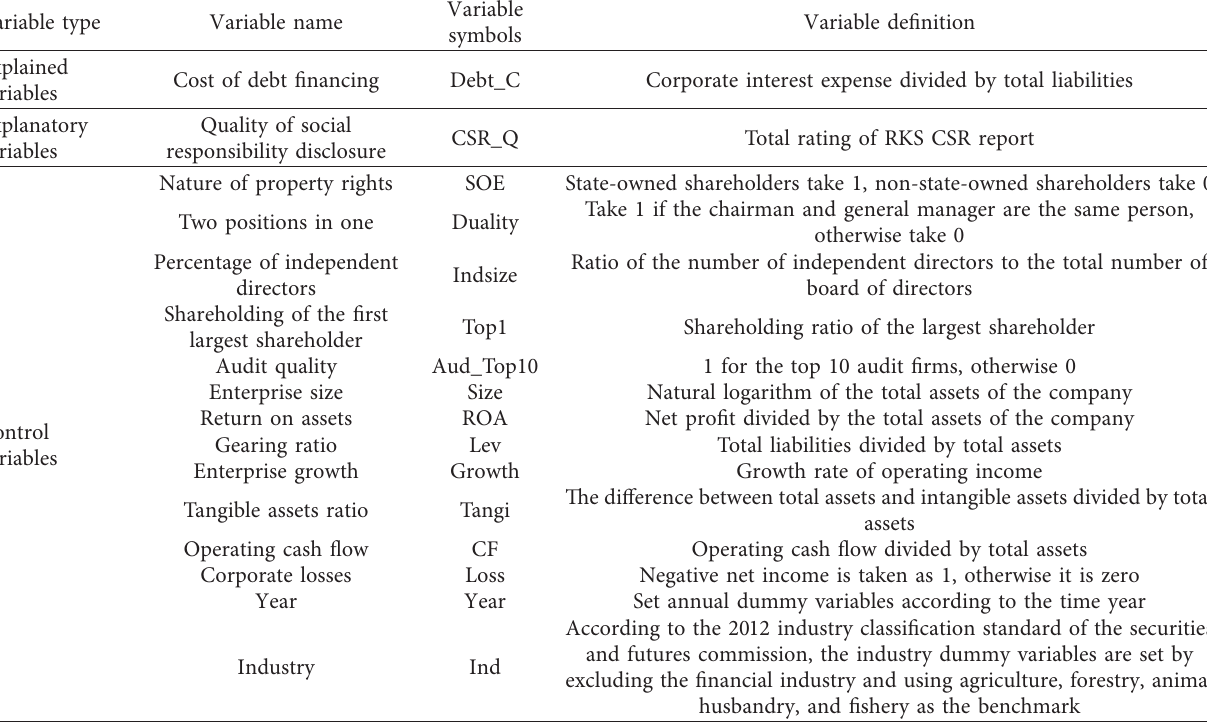
Table 1: Definition of variables.